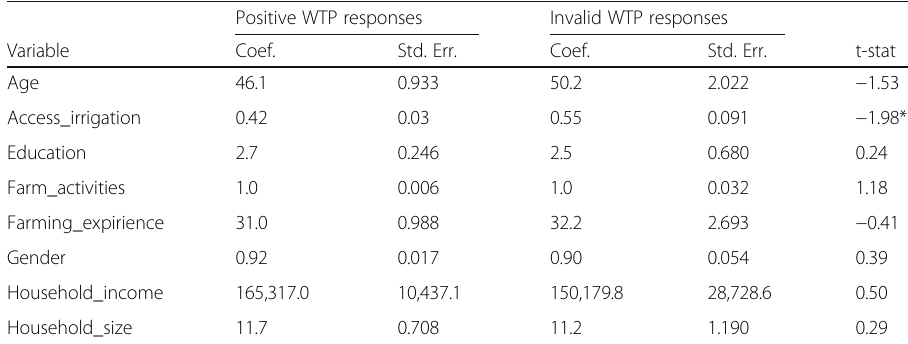
Table 3 Comparison of means for ‘ valid/invalid ’ WTP